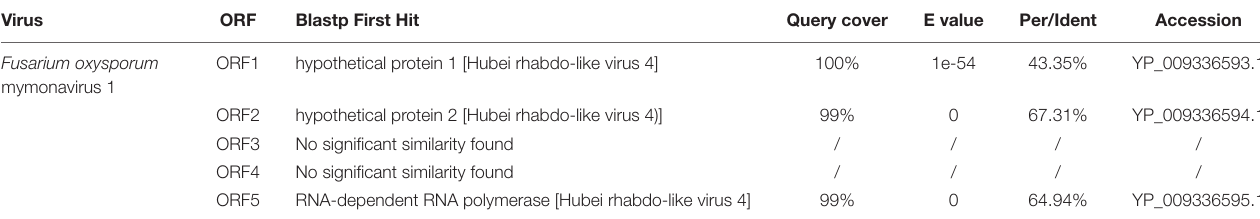
FIGURE 2 | Genome organization of a mymonavirus from the F. oxysporum strain LJ3-3. (A) Schematic diagram of the genome organization of Fusarium oxysporum mymonavirus 1 (FoMyV1). FoMyV1 shows the presence of five ORFs. The black bars indicate the coding regions, and the gray bars represent the untranslated regions on the genome of FoMyV1. The four green arrowheads point out the location of the putative gene junction sequence. (B) Comparison of putative gene-junctions between ORFs in the FoMyV1, alignment of the putative junction sequences are shown in the 3 (cid:48) –5 (cid:48) orientation. (C) Complementarity between the 3 (cid:48) - and 5 (cid:48) -terminal sequences of FoMyV1 genomic RNA strand. (D) Multiple alignments of the amino acid sequences of RdRp in the protein L encoded by FoMyV1 and other (–)ss RNA viruses. The abbreviations of virus names are listed in Supplementary Table 4 .